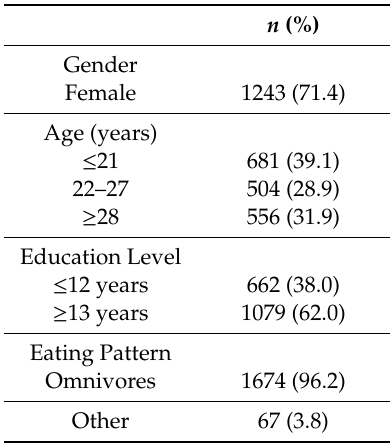
Table 2. Participants’ characteristics.